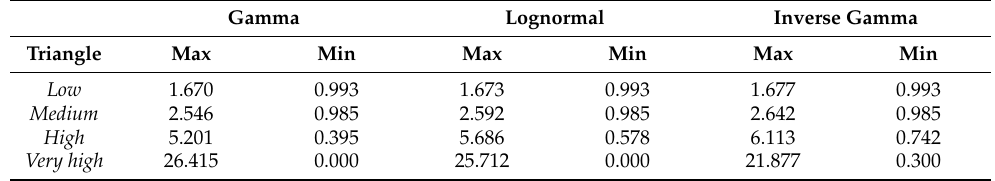
the range from 0.25 to 6.5, which is acceptable from practical point of view. For very high triangles, we observe that the range of the simulated individual development factors is much larger, and they may attain 0 and go up to around 25. As commented in the paper, we constructed very high triangles so that they serve as the most extreme case observable in practice. The results for the case with the estimation error are very similar and are omitted. Table A1. The maximum of quantiles of order 99.5% and minimum of quantiles of order 0.5% across all accident years and development periods in the simulation study without the estimation